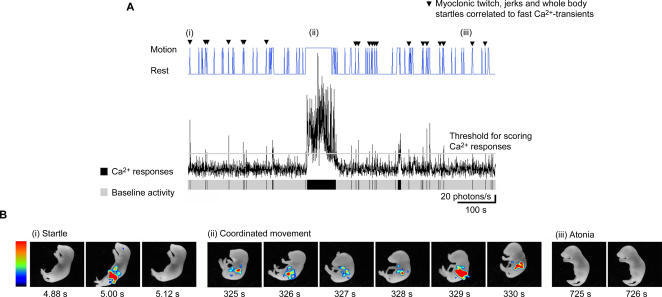
Distinct mitochondrial Ca2+ responses in newborn mice are linked to different behavioral states.A newborn mouse (P1) was injected (i.p.) with coelenterazine and whole animal bioluminescence was co-registered with the video image with an acquisition rate of 25 Hz using the Video Imager. (A) Graph shown in black is the total light intensity (photons/s) detected during more than 700 s of recording. The thin grey line running through the graph shows the minimum threshold set for scoring Ca2+-responses whose amplitudes reach or go above this limit. The upper blue graph shows the cycling between motion and rest, which was determined by visual analysis of the video frames. Closed black arrow heads show where fast Ca2+-transients (<1 s duration) are correlated to muscular twitches or whole body startles. Sustained Ca2+-responses (>1 s duration) are associated with coordinated movements. The lower grey bar shows periods of baseline Ca2+ activity (below the threshold line set) together with black bars that represent the Ca2+-responses and their durations. (B) Examples of the three behavioral states visually characterized; including (i) whole body startle, (ii) co-ordinated movement and (iii) atonia. Data for each state represents the video image superimposed with the bioluminescence image at the times indicated on each frame and in Figure 5A. (i). Frames represent 40 ms integration of the bioluminescence superimposed to the corresponding video image. Color scale is 0.000725–0.00145 photons/pixel (5 mm smoothing has been applied). (ii & iii) represents 160 ms integration of the bioluminescence superimposed to the corresponding video frame. Color scale is 0.00174–0.00377 photons/pixel (3.5 mm smoothing). The FOV used in these studies was 8×6 cm.